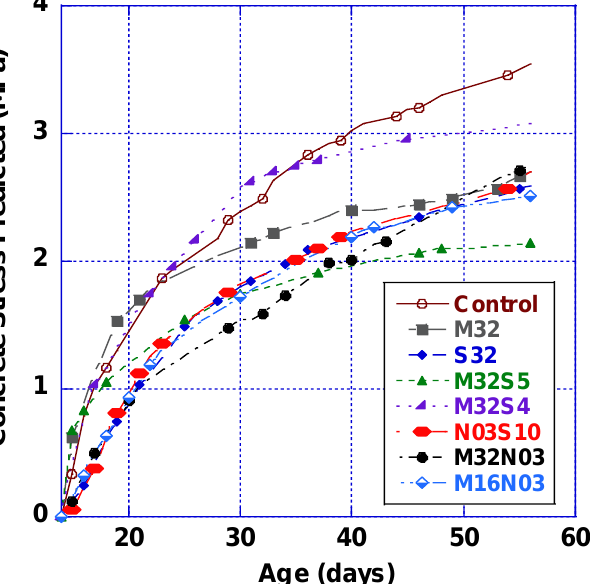
Figure 8. Steel ring strain: ( a ) 14 – 56 days and ( b ) 56 days. Additionally, predictions of the concrete stresses within the AASHTO ring test have been calculated using Hossain and Weiss ’s model [42]. In the absence of accurate methods to directly measure the restrained concrete stress, this method assesses the residual stress development in restrained concrete ring specimens and helps quantify the benefits of add- ing low volumes of hybrid fibers in reducing concrete-induced stresses. As illustrated in Figure 9, the average concrete stress is calculated based on the average strain measure- ment on the steel ring and compared to the cracking strain (direct tensile measurement). The results show that the concrete stress did not exceed the cracking capacity of the mix and adding hybrid fibers reduced the concrete stresses, which was also reflected in the cracking area observed on the ring surfaces.